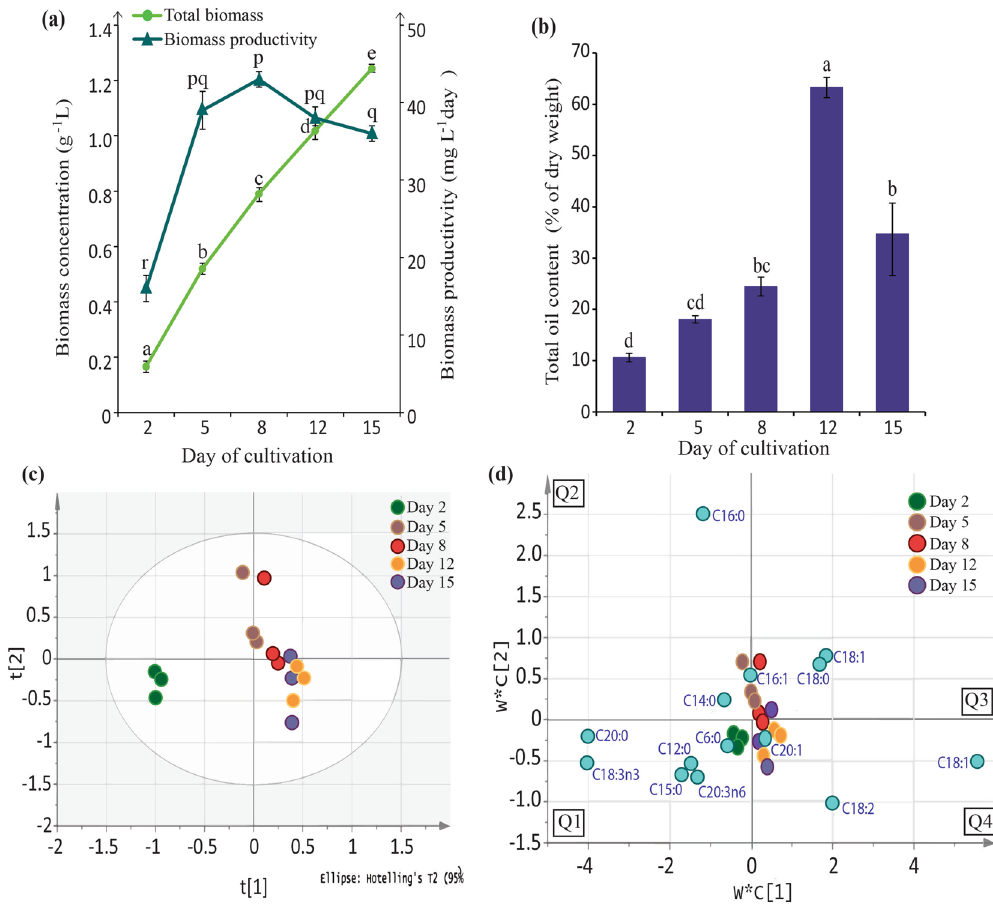
Figure 4. Changes in (a) biomass production and biomass productivity, (b) total oil content along different growth phases observed at day 2, 5, 8, 12 and 15. C. vulgaris UMT-M1 cultures grown under selected salinity of 15 ppt. All values represent the mean ± SD from three biological replicates. Different series of letters represent significant differences within each parameter measured (Fisher’s LSD (SPSS software), p < 0.05). Prediction of fatty acid profile was carried out using PLS-DA (SIMCA) where ( c ) score plot shows how closely related each time-points are while ( d ) generated PLS-DA scores loadings plot show the predominant fatty acid changes through the growth phases. Loadings (blue dots) represent fatty acid type. Eclipse in (c) represents 95% confidence level. (R 2 X = 0.714, R 2 Y = 0.97, Q 2 = 0.984). Q1–Q4 represent the 4 quadrants of the score/loadings